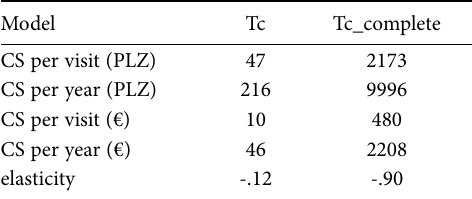
Table 5. Marginal consumer surplus and elasticity derived from the different